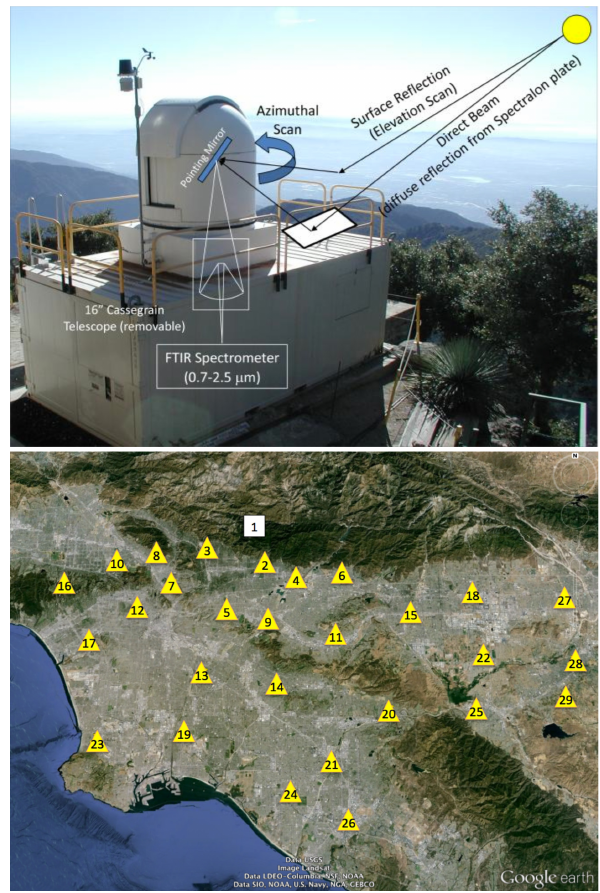
Figure 1. The CLARS-FTS on Mount Wilson (top) and its 29 re- flection points on Mount Wilson and in the Los Angeles megacity (bottom). Reflection points are labeled in the order of increasing distance from the FTS. Information of the reflection points is given in Table 1. A small fraction of the central Los Angeles megacity area cannot be viewed from Mount Wilson due to a nearby moun- tain